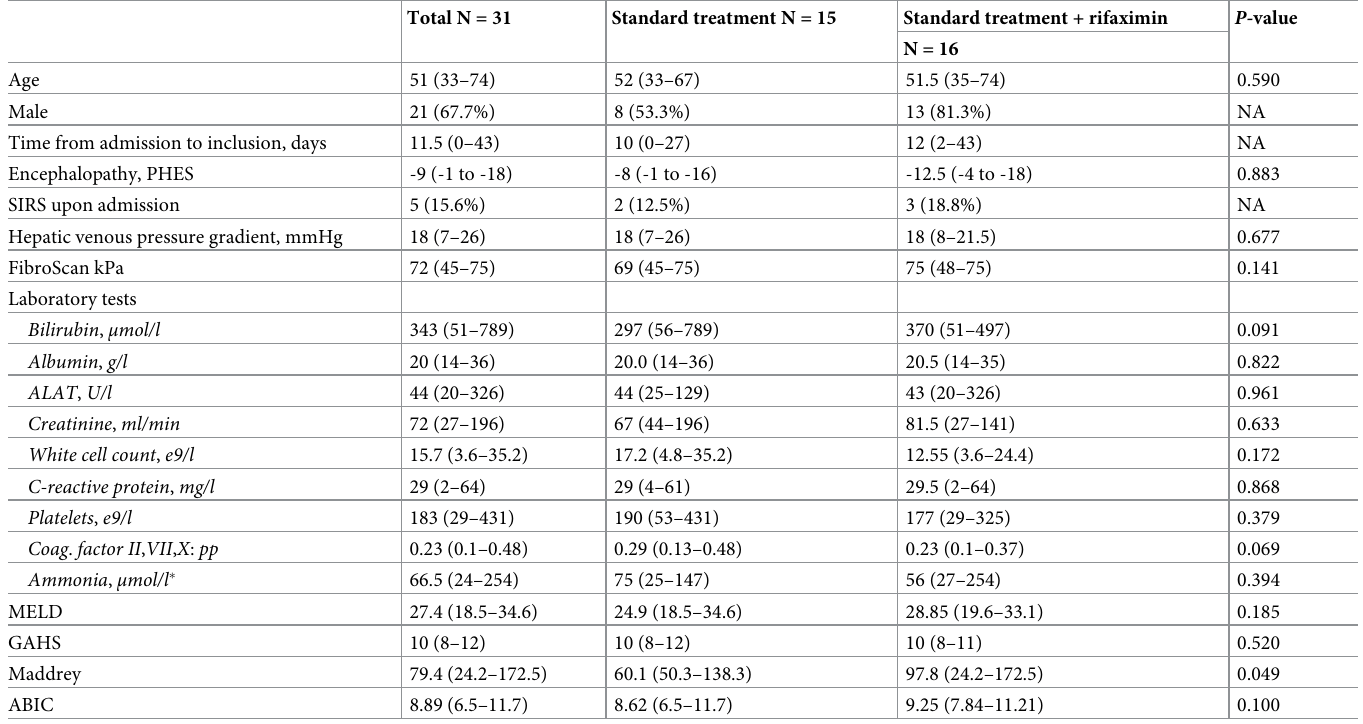
Table 1. Baseline characteristics.